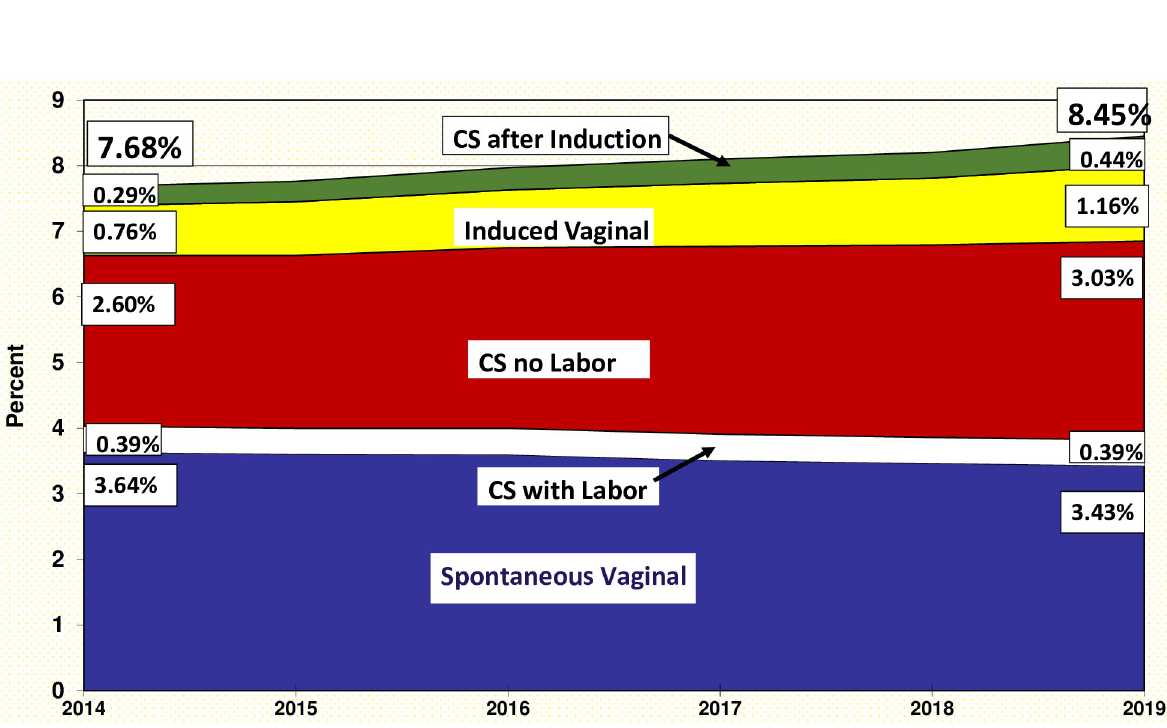
Fig 2. Percentage of singleton preterm births, out of total births, by method of delivery, United States, 2014–2019.